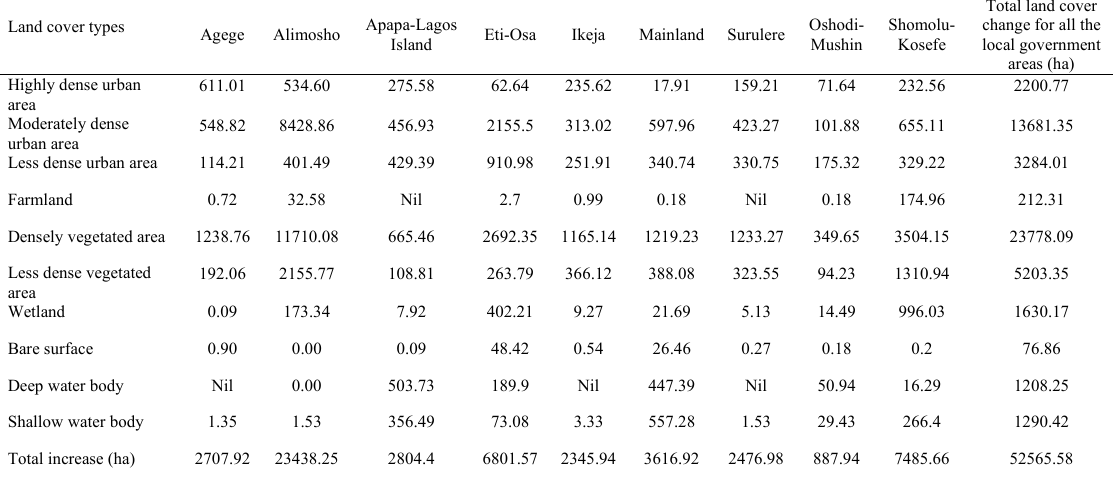
Table 1: Change detection for the various land cover types for all local government areas between 2002 and 2013 (ha)